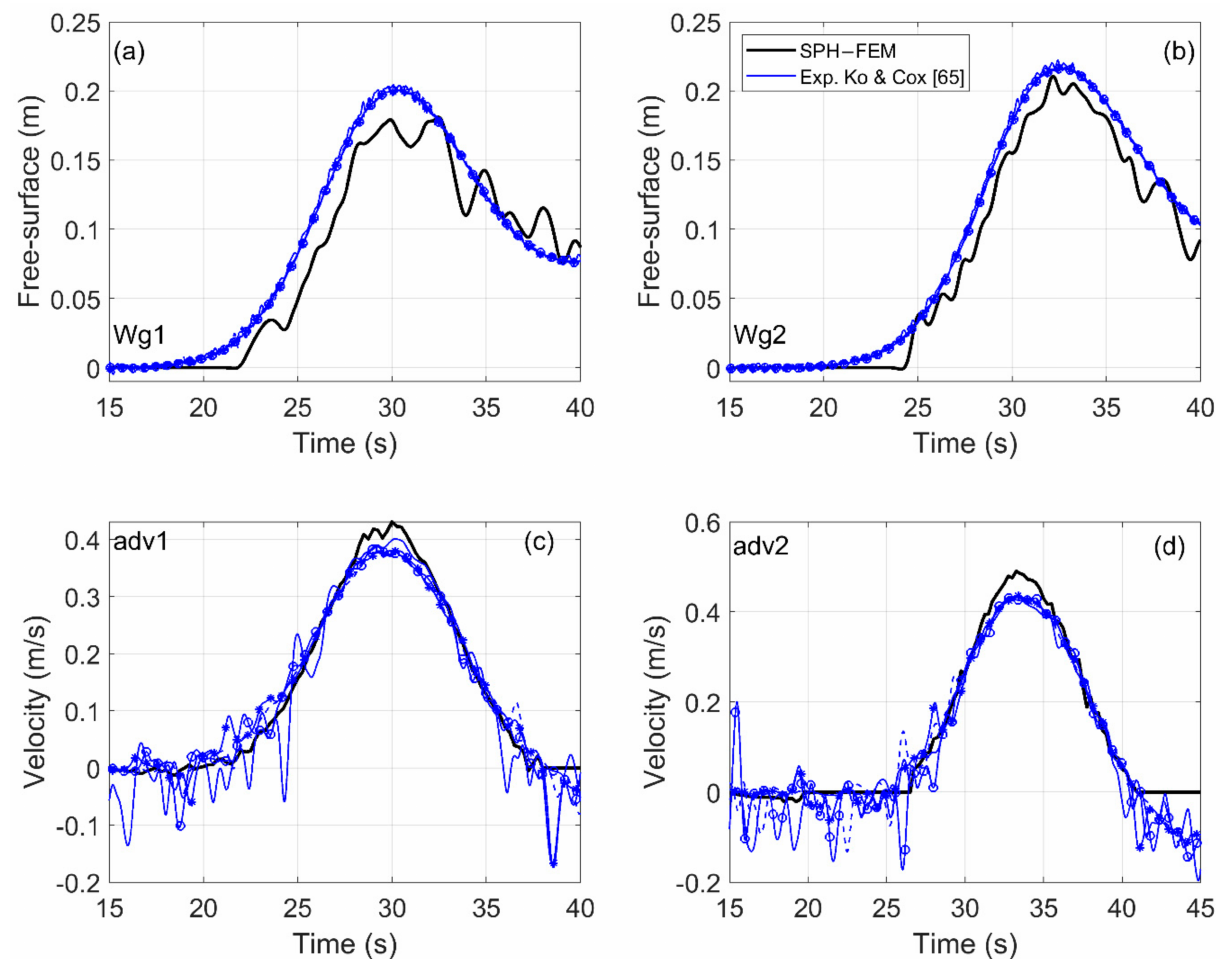
Figure 3. Variation of the free surface and fluid velocity at different locations along the flume. Experimental [65] and numerical results for h 1 = 2.496 m and T erf = 30